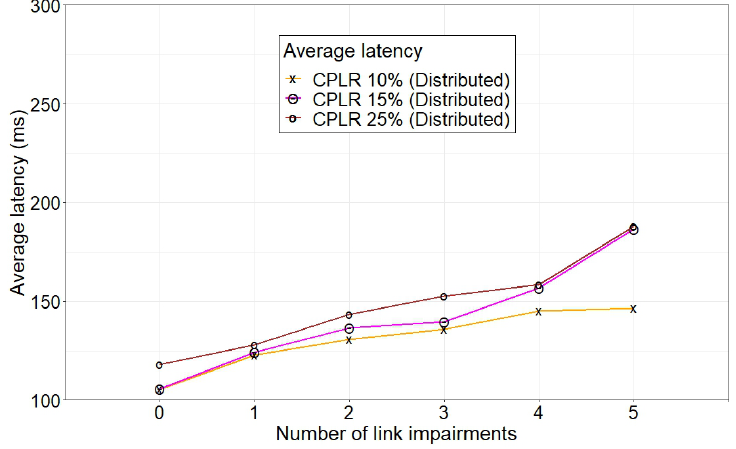
Figure 13. Average latency behavior of distributed network operation, during data plane link failures for various times under unreliable channel conditions in a 9-node grid